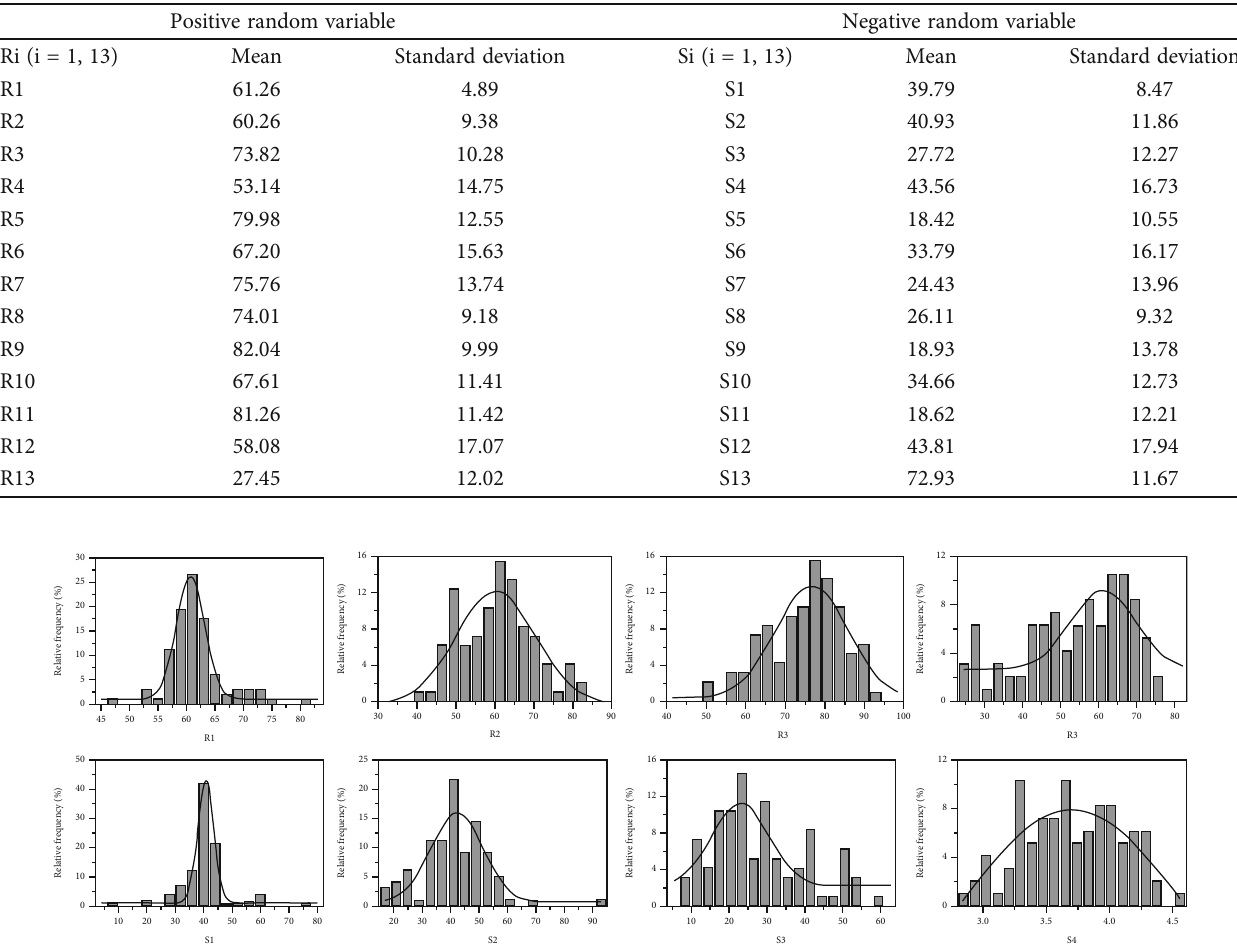
Figure 4: Probability density distribution of the random variables in abundance of geological resources ( R 1 – R 4 , S 1 – S 4